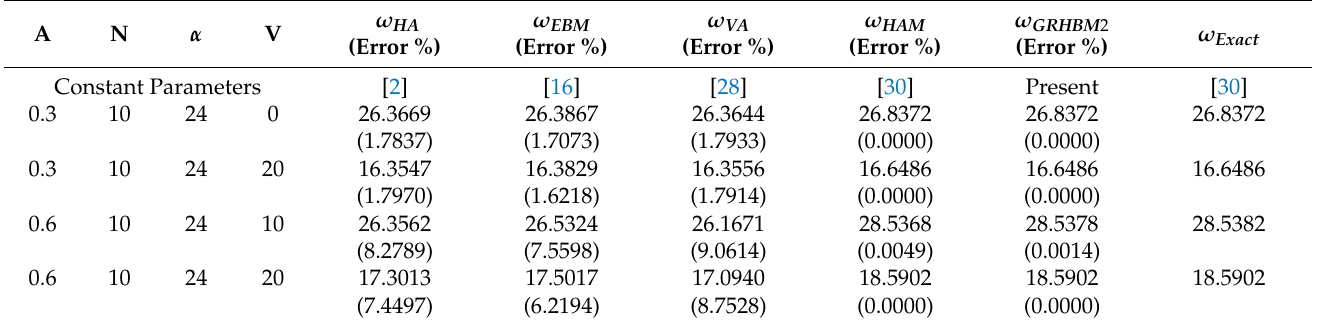
Table 1. Comparison of the approximated frequencies with corresponding exact frequencies based on the various parameters in Equation